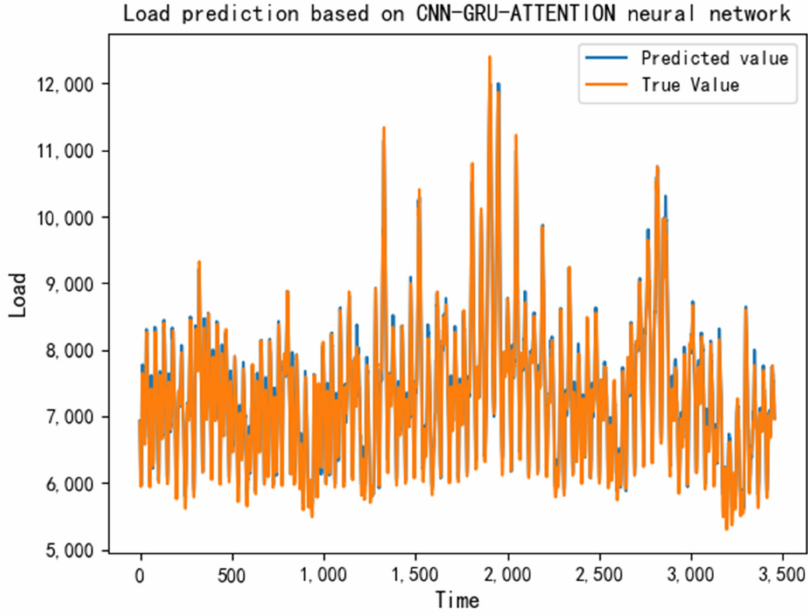
Figure 6. Load prediction based on CNN-GRU-ATTENTION neural